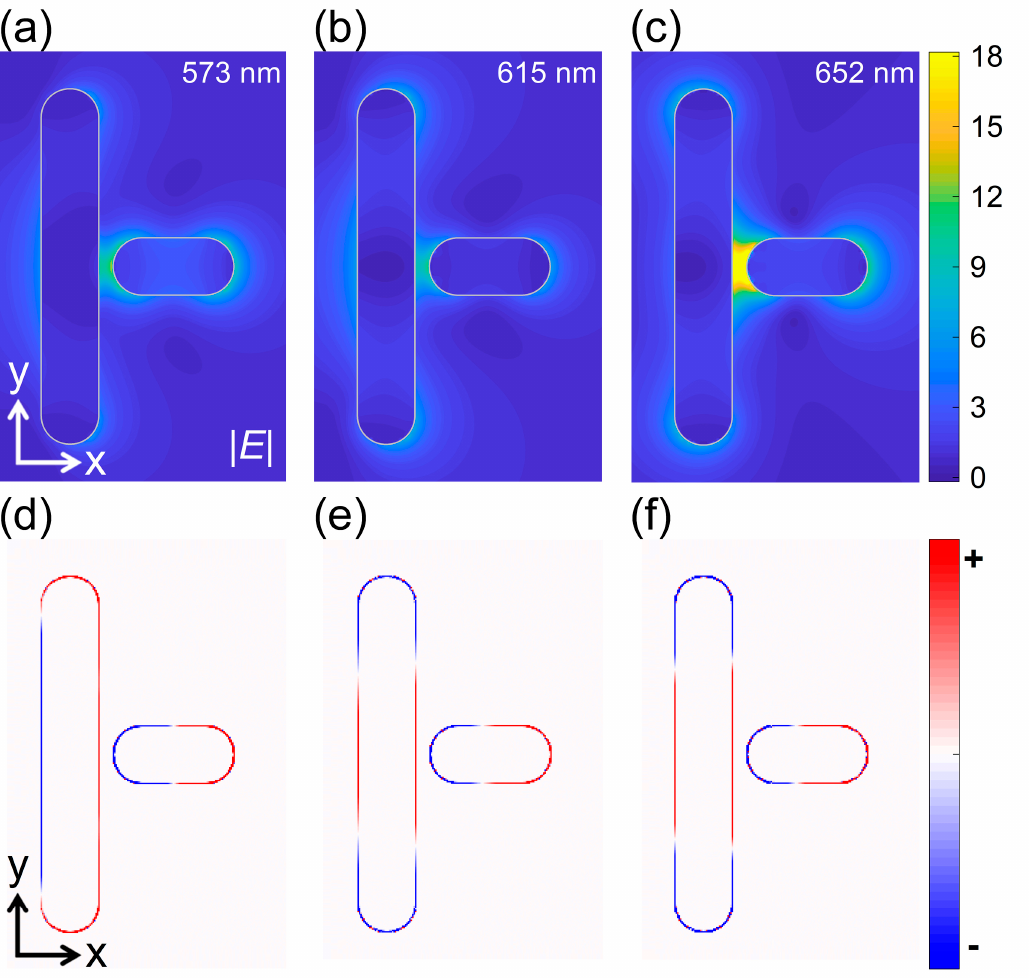
Figure 3. Electric field (upper panel) and surface charge (lower panel) distributions calculated for the T-shaped GNR with L l = 248 nm, L s = 84 nm and w = 10 nm at different wavelengths. ( a , d ) λ = 573 nm, ( b , e ) λ = 615 nm, ( c , f ) λ = 652 nm.